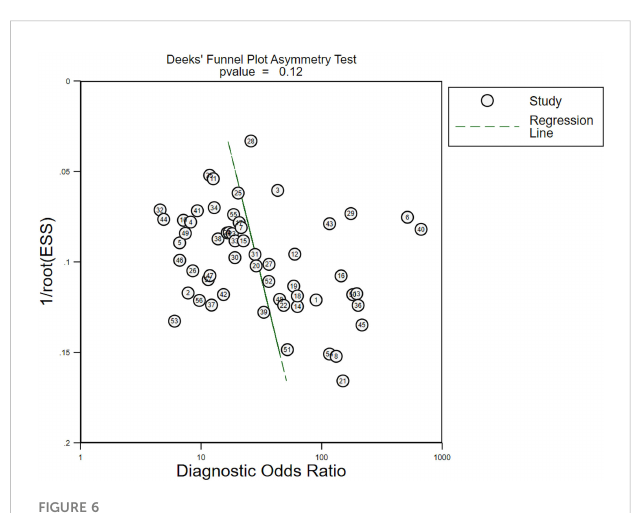
FIGURE 6 Publication bias assessment of all included